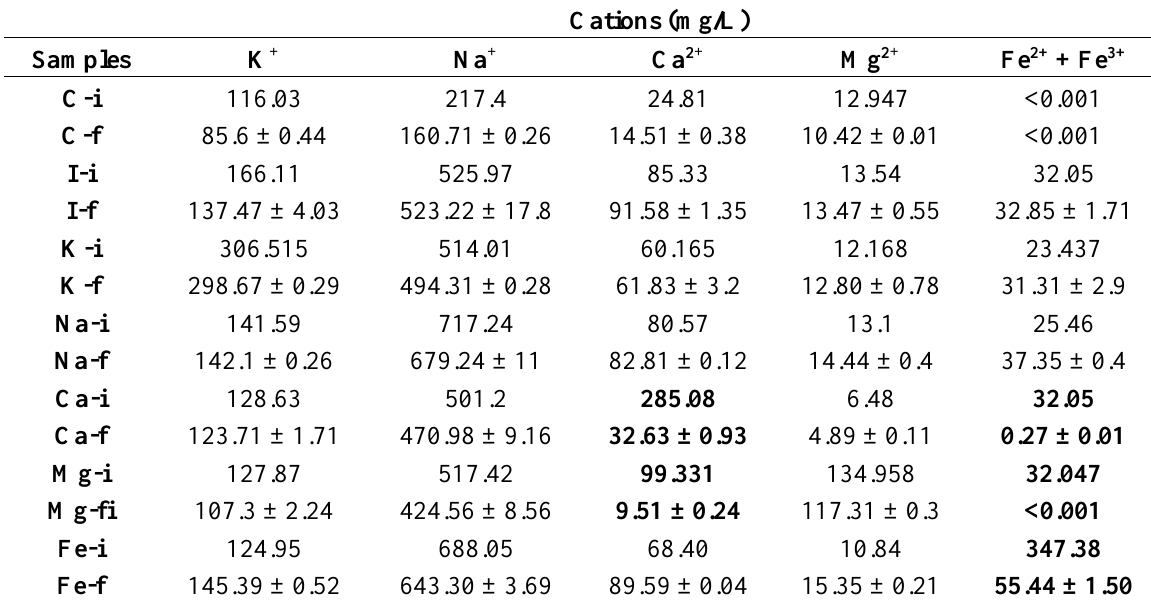
Table 2. Cation concentrations of the experimental groups in the beginning (initial = i) and at the end (final = f) of the experiment. Results of each experimental group abbreviated with; positive control (C), inhibition groups (I), salt addition groups of calcium (Ca), magnesium (Mg), iron (Fe), sodium (Na) and potassium